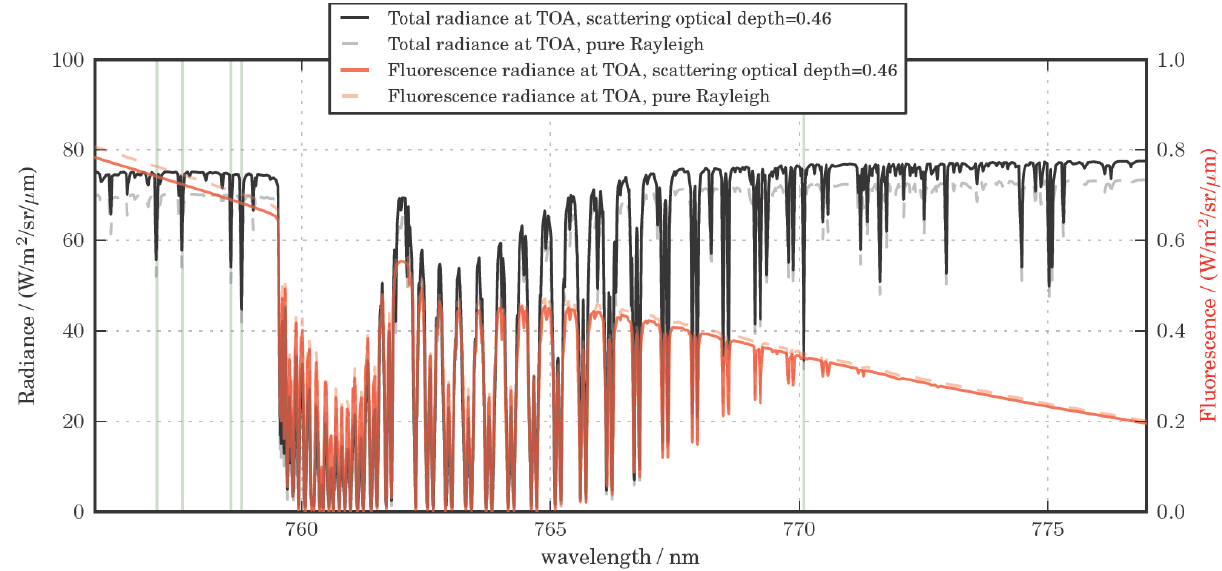
Fig. 2. Simulated noise-free spectrum with GOSAT spectral resolution. Solar zenith angle = 26 . 35 ◦ ; surface albedo ≈ 0 . 2; aerosol + cloud optical depth = 0 . 46. The fluorescence spectrum at the TOA is modeled once in a pure Rayleigh atmosphere and once including aerosol and cloud scattering of the emission emanating from the surface. Positions of Fraunhofer lines most suitable for fluorescence retrievals in the GOSAT spectral range are indicated by green lines.